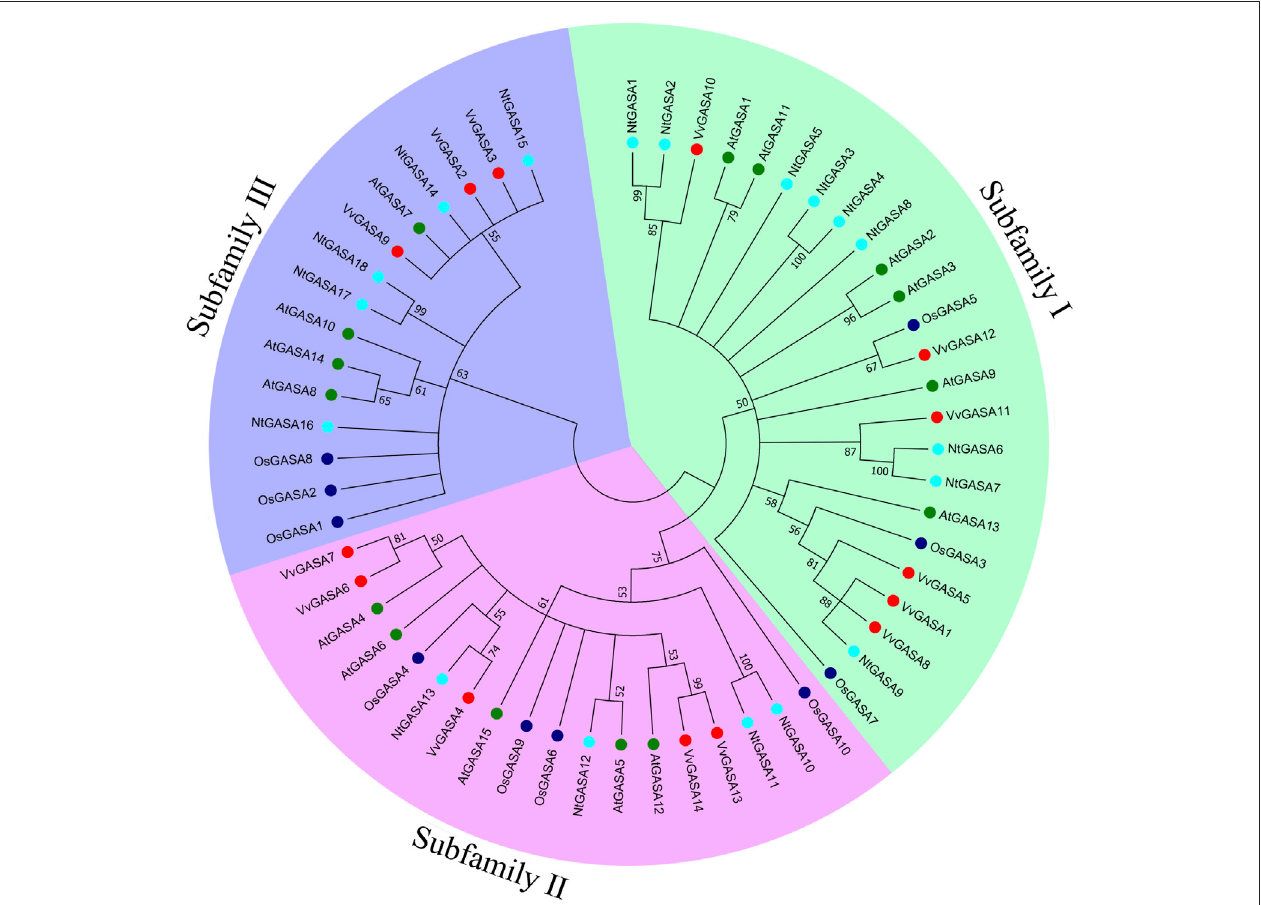
FIGURE 1 | Phylogenetic analysis of GASA proteins from Arabidopsis , rice, grapevine and tobacco. A total of 15 GASA proteins from Arabidopsis , 10 GASA proteins from rice, 14 GASA proteins from grapevine, and 18 NtGASA proteins from tobacco were used to generate the unrooted neighbor-joining (NJ) tree with 1,000 bootstrapreplicates. TheGASAproteinsareclassi fi edintothreesubfamilies(markedasI,II,III),anddistinguished bydifferentcolors:AtGASAlabeledingreen,OsGASA labeled in blue, VvGASA labeled in red, and NtGASA labeled in cyan.